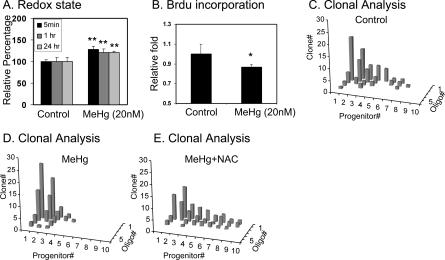
MeHg Exposure Makes O-2A/OPCs More Oxidized, Suppresses BrdU Incorporation, and Decreases Cell Division in Clonal Assays(A) Purified O-2A/OPCs were grown in the presence of 10-ng/ml PDGF overnight. Effects of MeHg on intracellular redox state were determined by analysis of 2′,7′-dichlorodihydrofluorescein diacetate fluorescence emission in O-2A progenitors exposed to 20 nM MeHg for various lengths of time, as indicated.(B) Cells were plated in medium containing PDGF and then exposed to 20 nM MeHg for an additional 72 h. During the last 4 h of exposure, cultures were also exposed to BrdU. Cultures were then stained with A2B5 and anti-BrdU antibodies (to recognize all progenitors and those synthesizing DNA during the BrdU pulse, respectively). Results are presented as comparison with control cultures.(C–E) Suppression of cell division by exposure to MeHg was studied in more detail at the clonal level. Cells were treated as for (B), except for being plated at clonal density (as in [59,199]). Cultures were maintained for 6 d, and then 100 randomly chosen clones were analyzed for their composition (as in [59,64,199]). Data are presented, for all clones analyzed, in three dimensions such that the x-axis equals the number of progenitors per clone, the z-axis equals the number of oligodendrocytes (Oligo) per clone, and the y-axis equals the number of clones with any given composition. In cultures exposed to MeHg, there was a decrease in the representation of large clones and a proportionate increase in the number of small clones and clones containing oligodendrocytes. The effects of MeHg were prevented by co-exposure of cells to 1 mM N-acetyl-L-cysteine (NAC).All experiments were repeated at least three times, and all numerical values represent means ± SD for triplicate data points.